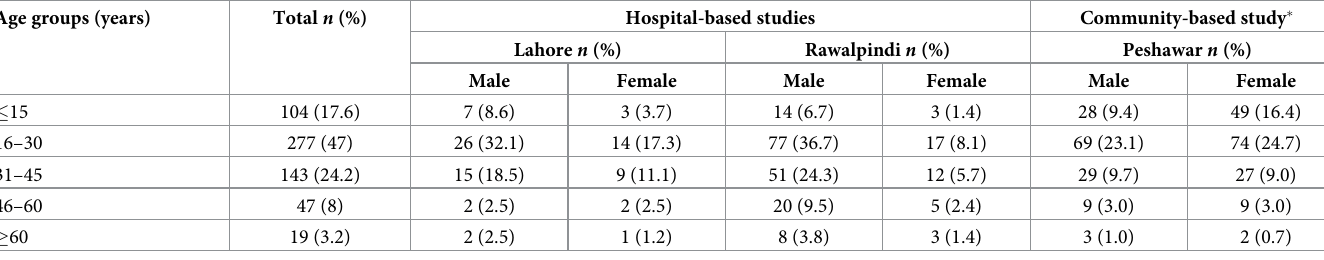
Table 1. Age distribution of the participants from different study sites. Age groups